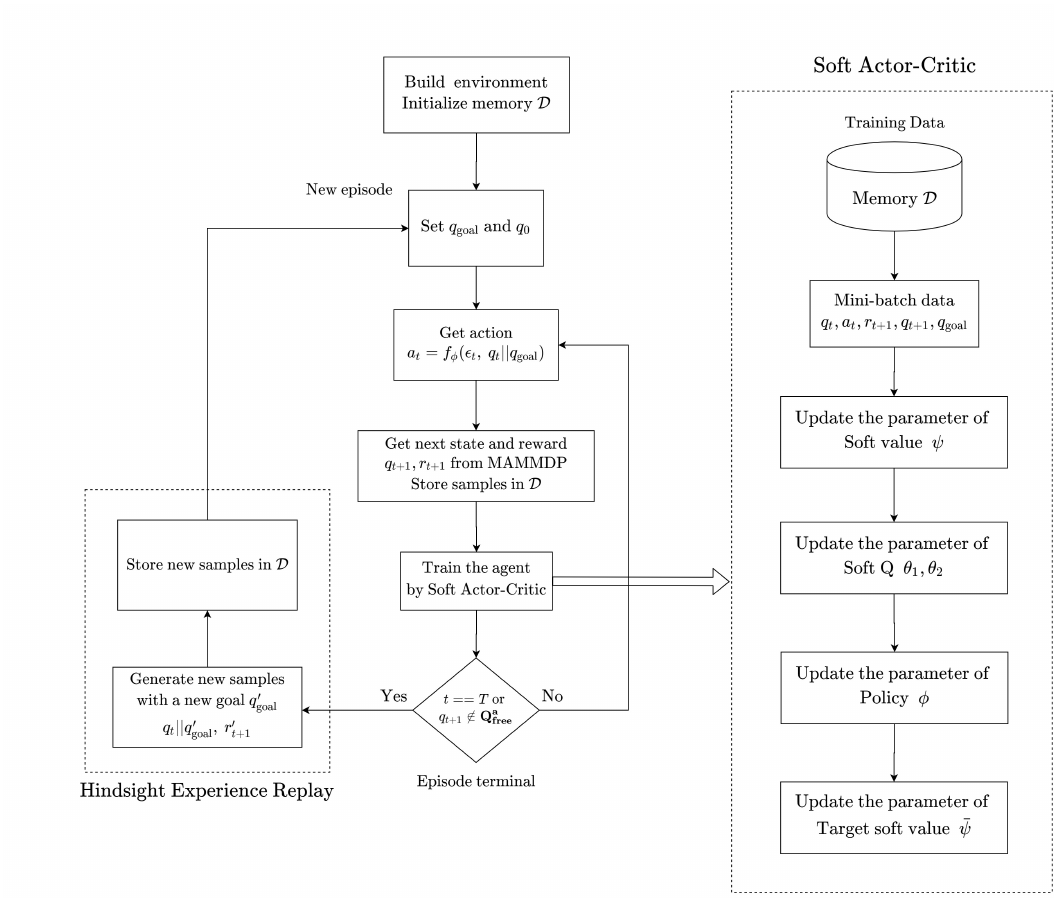
Figure 4. Flow chart of the proposed SAC-based path planning